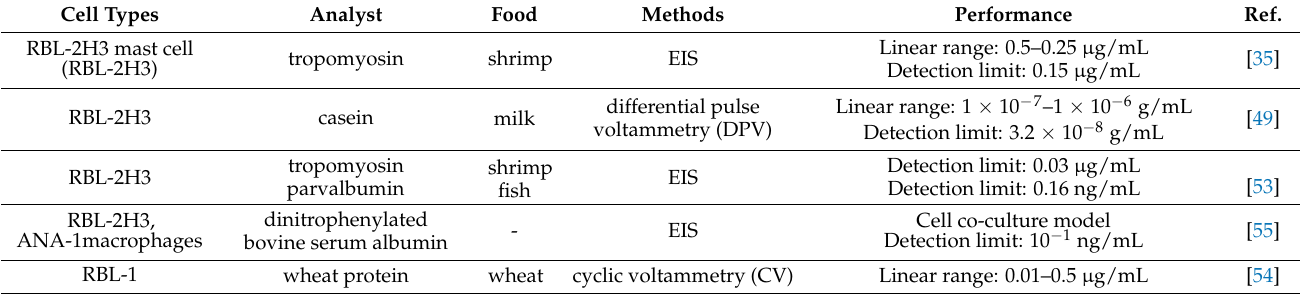
Figure 3. Food allergy mechanism. Food allergy results from an overblown reaction of the immune system to a food allergen. Two steps are necessary for this occurrence: an initial phase of sensitization to a specific antigen ( A ) and the elicitation of an allergic reaction after a second exposure to the same antigen ( B ). Table 2. Application of electrochemical cell-based sensor in detection of food